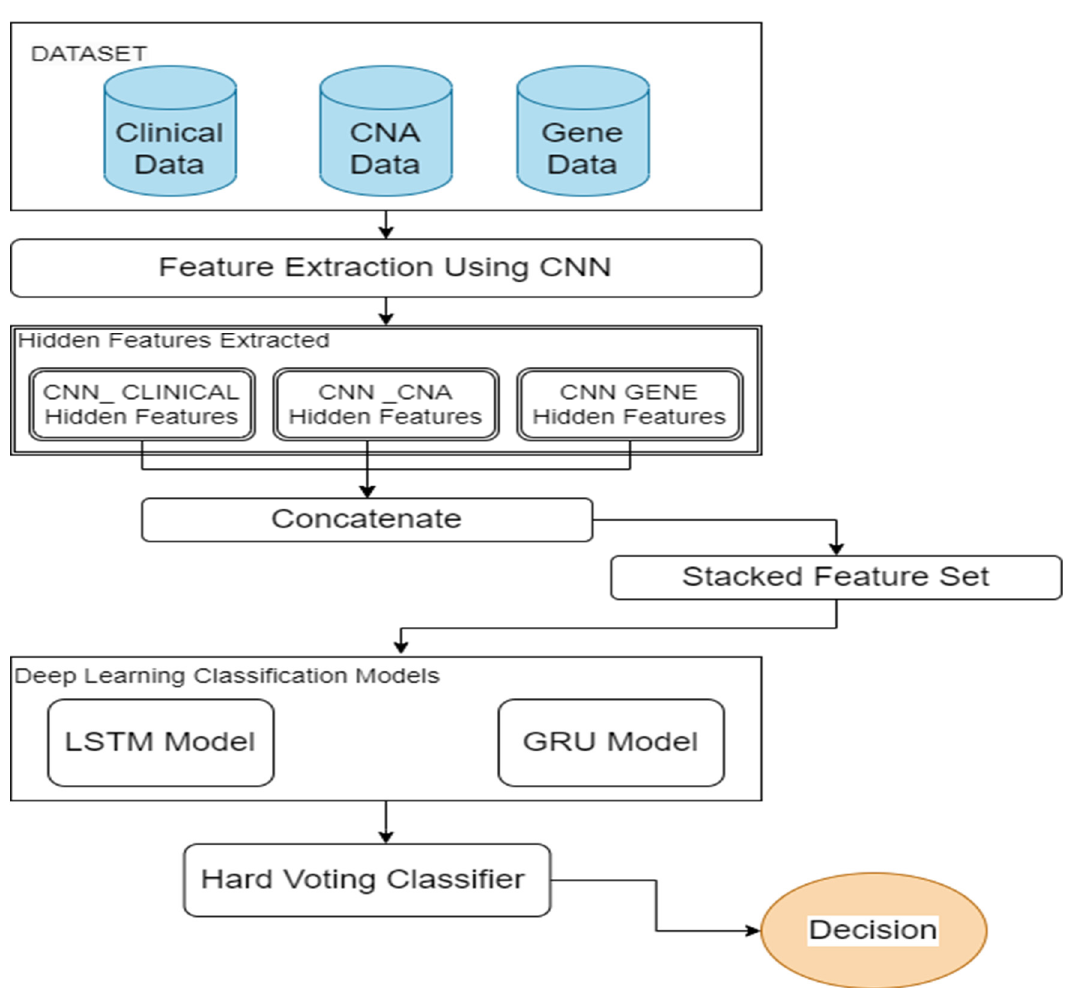
Figure 1. The workflow of the breast cancer survival prediction process.